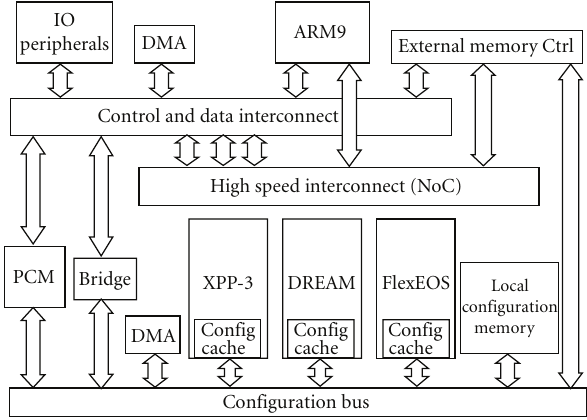
Figure 3: The considered platform is architected around three heterogeneous reconfigurable cores interconnected by an